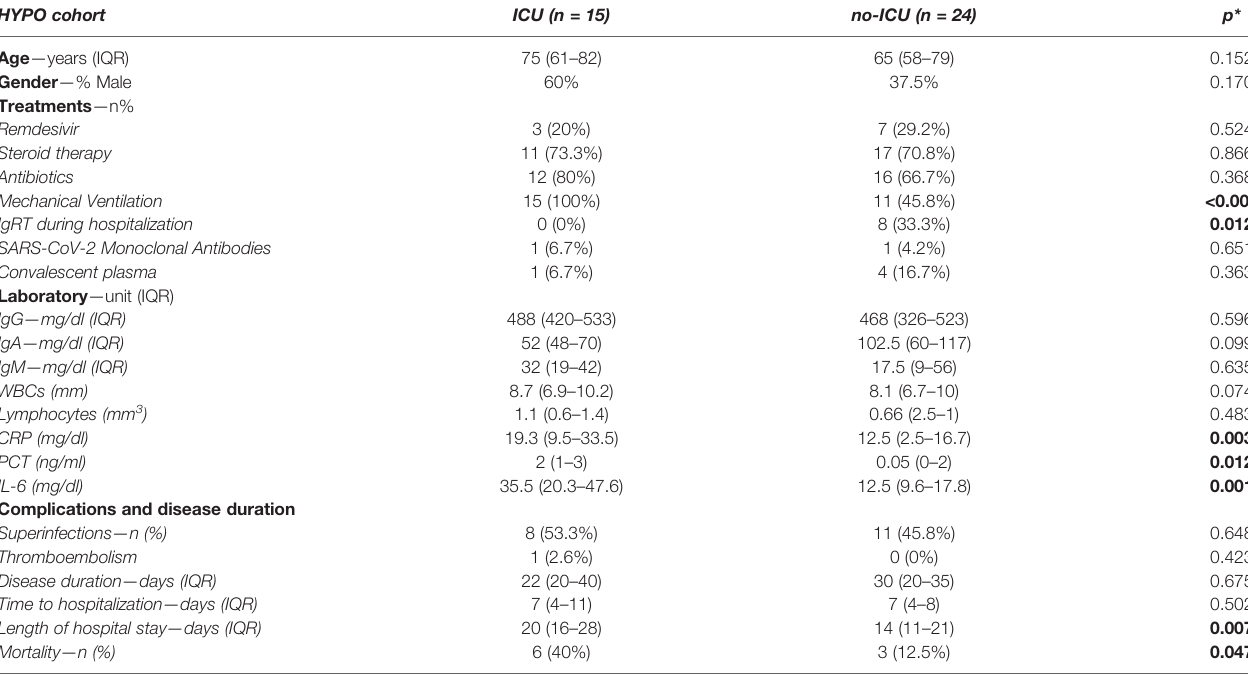
TABLE 6 | Clinical and laboratory outcomes between ICU vs. no-ICU among the HYPO cohort. HYPO cohort ICU (n =